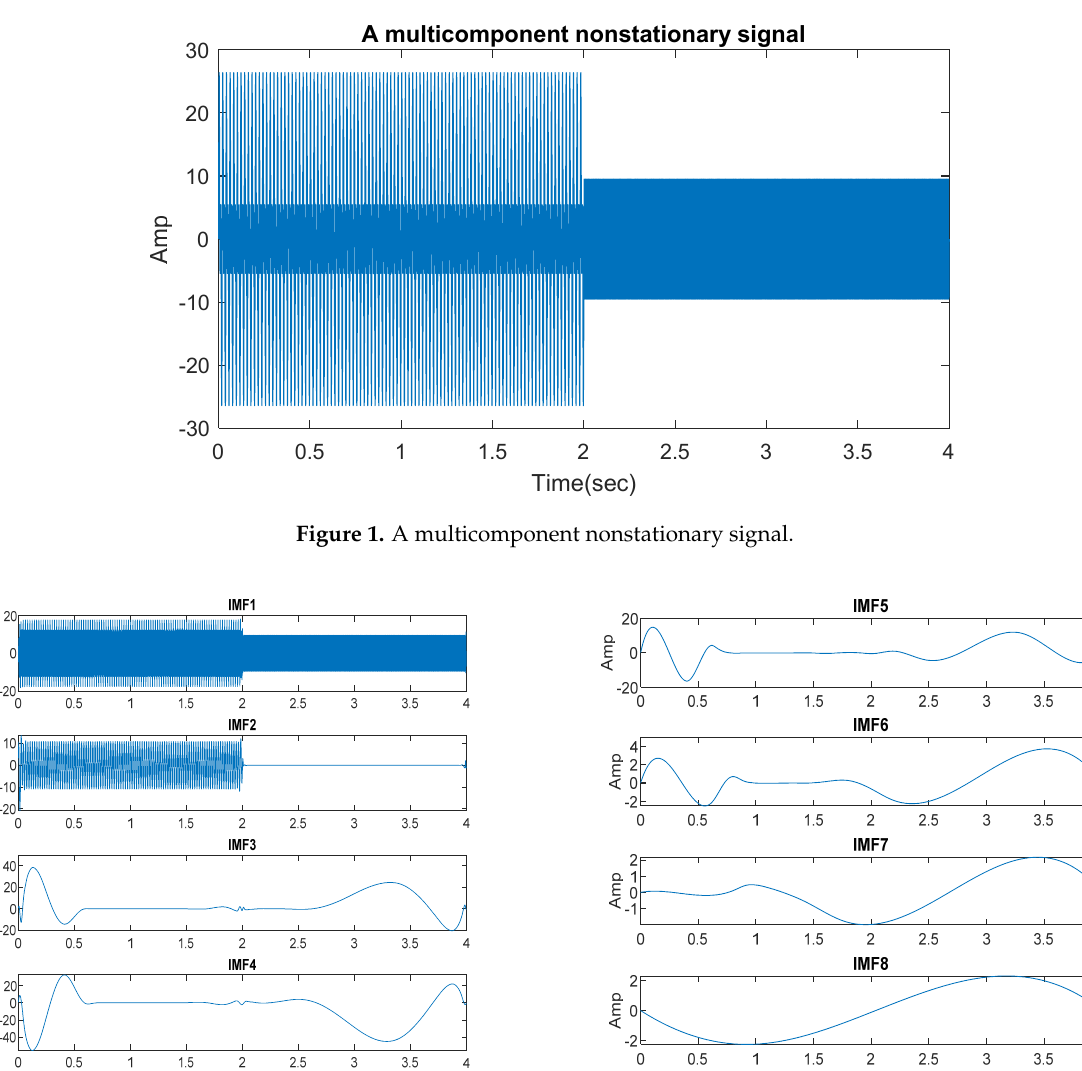
Figure 3. Instantaneous frequencies of the multicomponent nonstationary signal. This type of phenomenon occurs due to the cubic spline process inherent in EMD. During cubic spline process, large swings occur at both ends of the signal that can propa- gate inside the signal. As a result, whole signal gets corrupted, and some undesirable IMFs are produced in the low frequency region. Eventually, these undesirable IMFs may pro- vide misleading information regarding the health state of utility timber poles. Another shortcoming of HHT is that the first IMF contains a wide range of frequency in the high frequency region in practice [36]. Ideally, IMF should be nearly mono compo- nent but in case of IMF1, the mono component property cannot be achieved. Practical signals obtained from field contain more than one frequency at the same time, and IMF will not have one frequency component or narrow range of frequencies. Nevertheless, the instantaneous frequency of IMF1 will be still significant to some extent since IMF1 fulfils